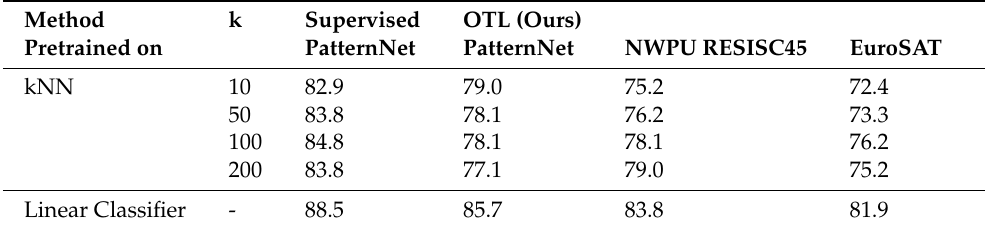
Table 6. HMHR: How-to-make-high-resolution-remote-sensing-image-dataset. Method